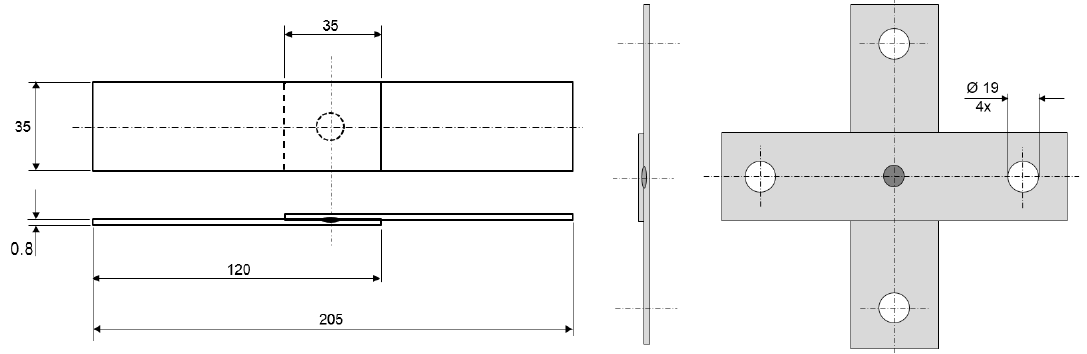
Figure 1. Schematic drawing of the test specimens used in the experiments, both for tensile shear tests and cross-tension test, respectively, dimensions based on AWS B4.0 standard.